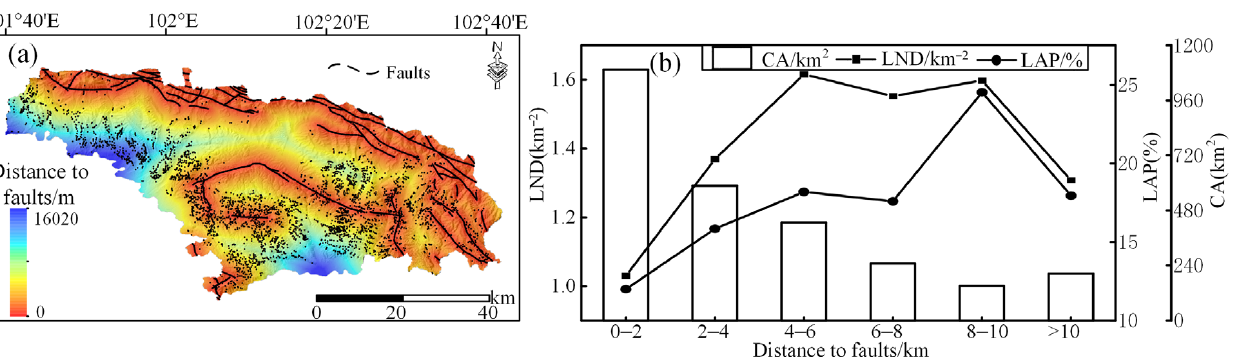
Figure 12. Relationship between the distance from the faults and the landslide distribution. ( a ) The distribution of the distance from the faults in the study area. ( b ) Statistics of landslide indicators in the intervals of the distance from the faults.